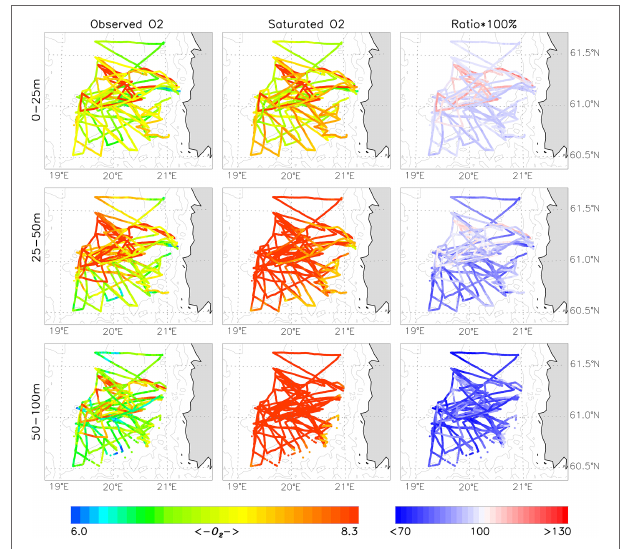
FIGURE 2 | Linear regression between glider and RV Aranda dissolved oxygen from simultaneous profiles. Comparisons were made at 59.78N and 20.11E (Åland Sea/Lågskär Deep) in 2017, at 59.53N and 23.28E (Gulf of Finland, explaining low O 2 concentrations) in 2019, at 61.08N and 19.58E (Bothnian Sea) in 2020, and at 60.03N and 20.16E (Bothnian Sea) in 2021. The regression equation adequately describes each year intercalibration indicating good quality of glider oxygen observations.